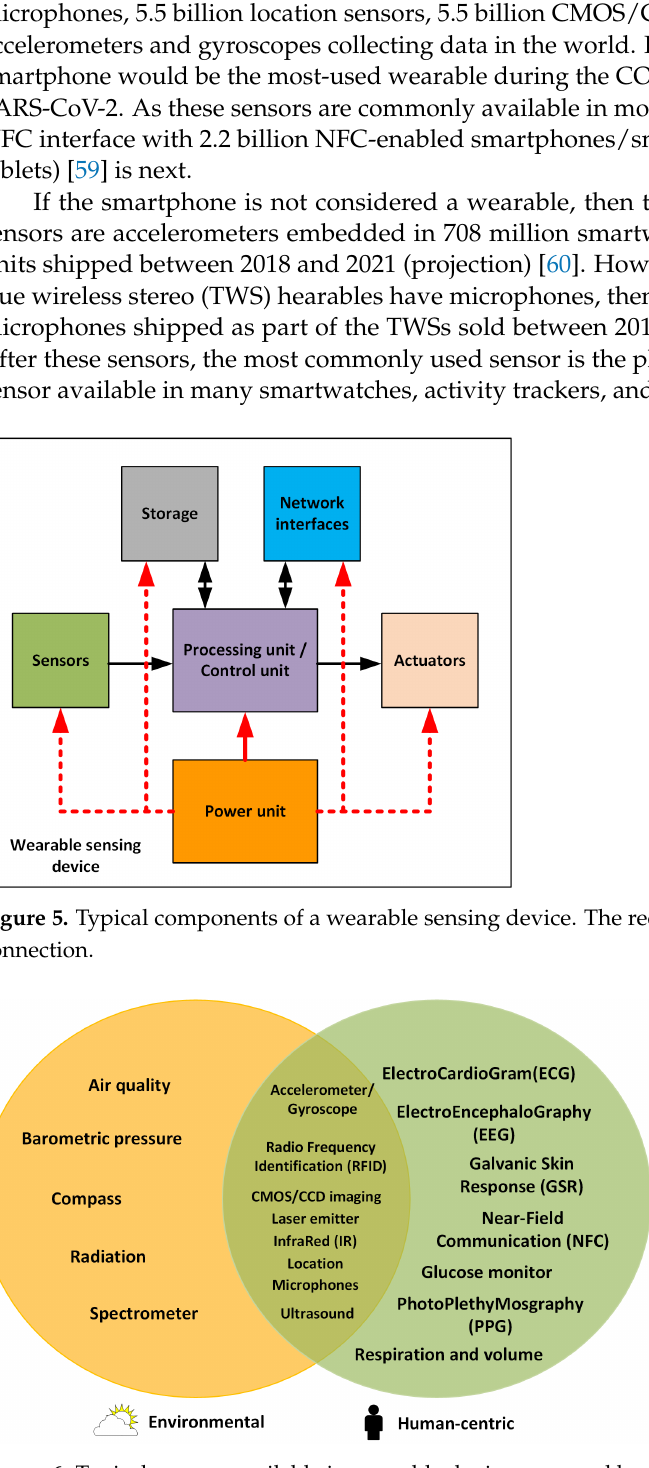
Figure 6. Typical sensors available in wearable devices grouped by type of collected